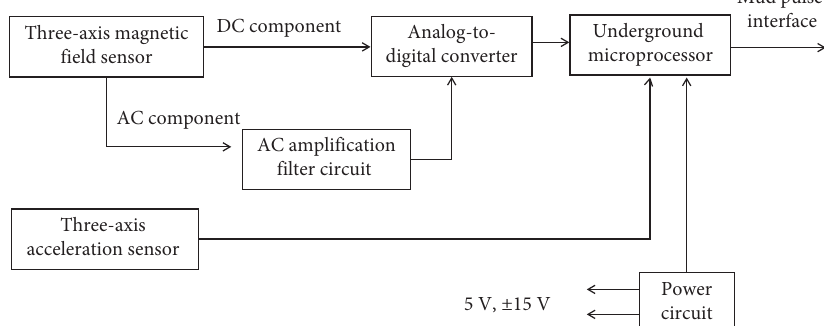
Figure 4: Overall structure diagram of signal processing circuit